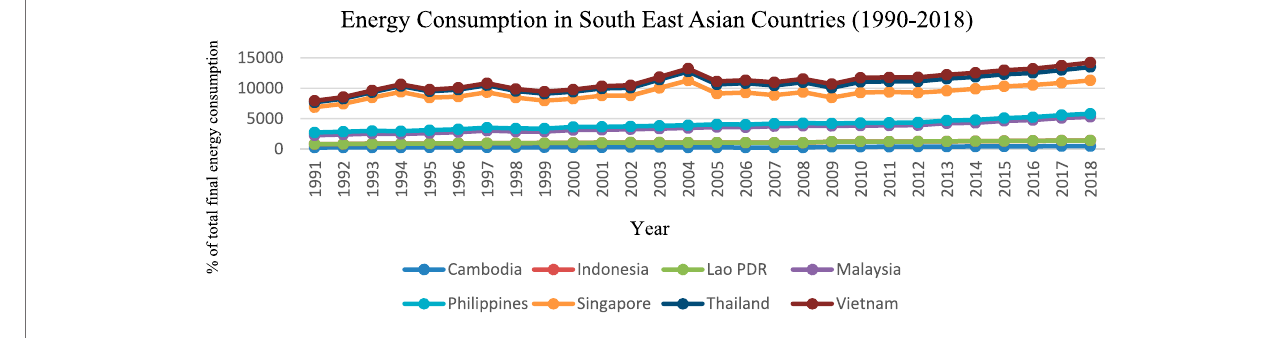
FIGURE 3 | Energy consumption of Southeast Asian countries.